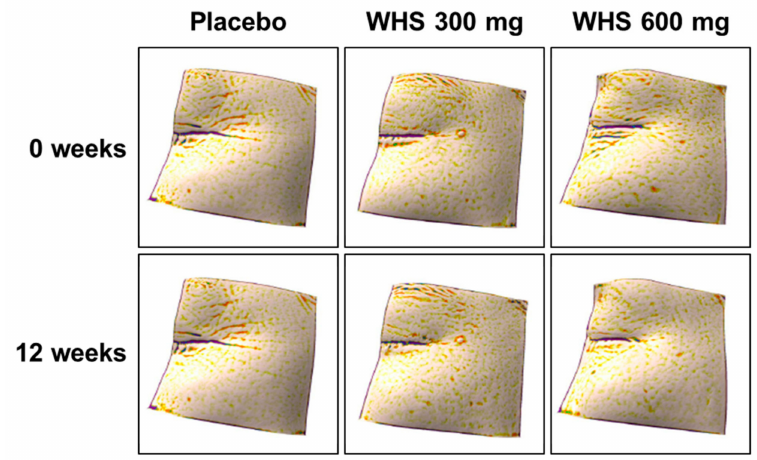
Figure 3. Representative crow’s feet 3D images in the WHS 300 mg group, WHS 600 mg group, or placebo group after 12